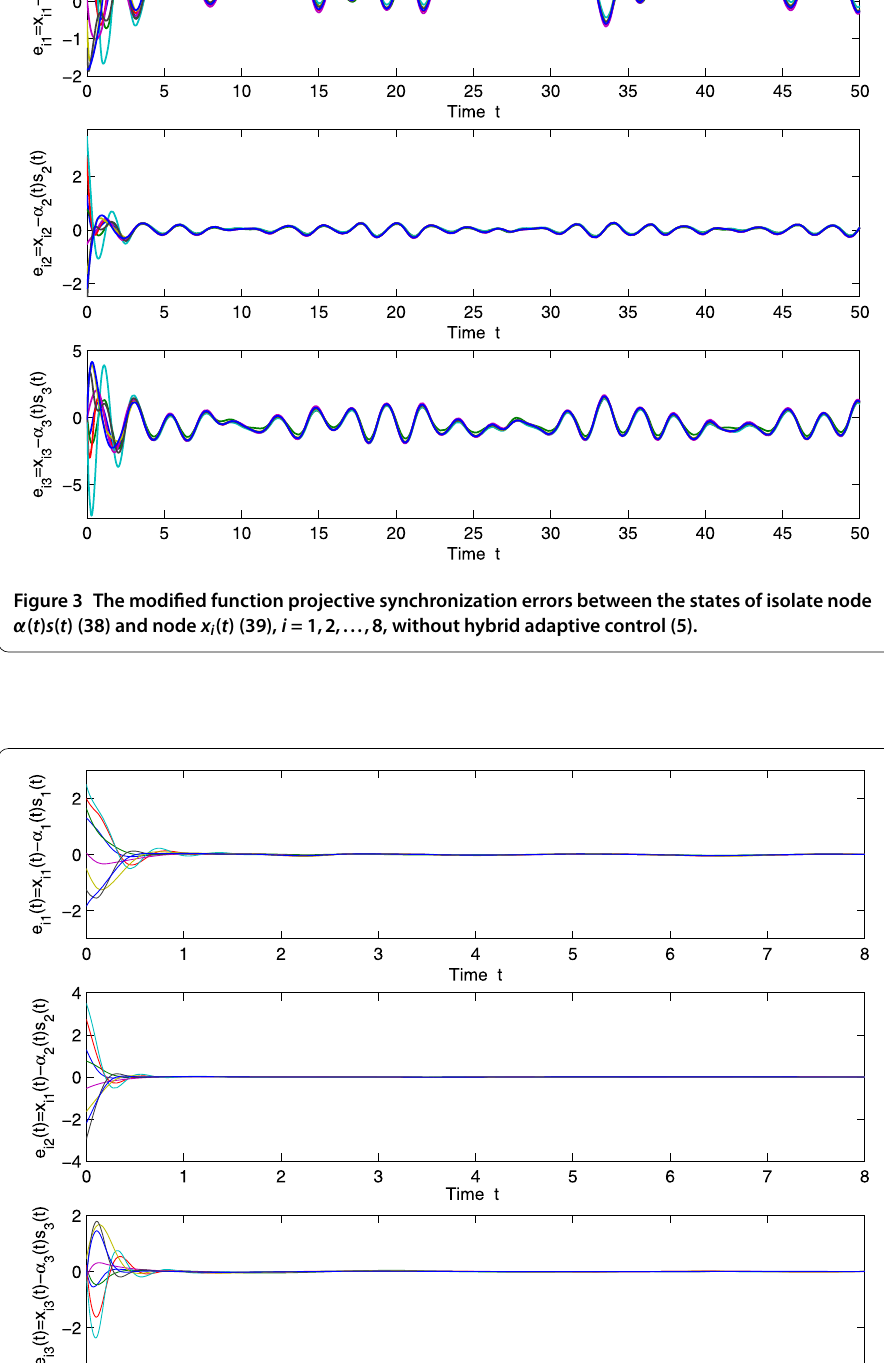
Figure 4 The modified function projective synchronization errors between the states of isolate node α ( t ) s ( t ) (38) and node x i ( t ) (39), i = 1,2,...,8, with hybrid adaptive control